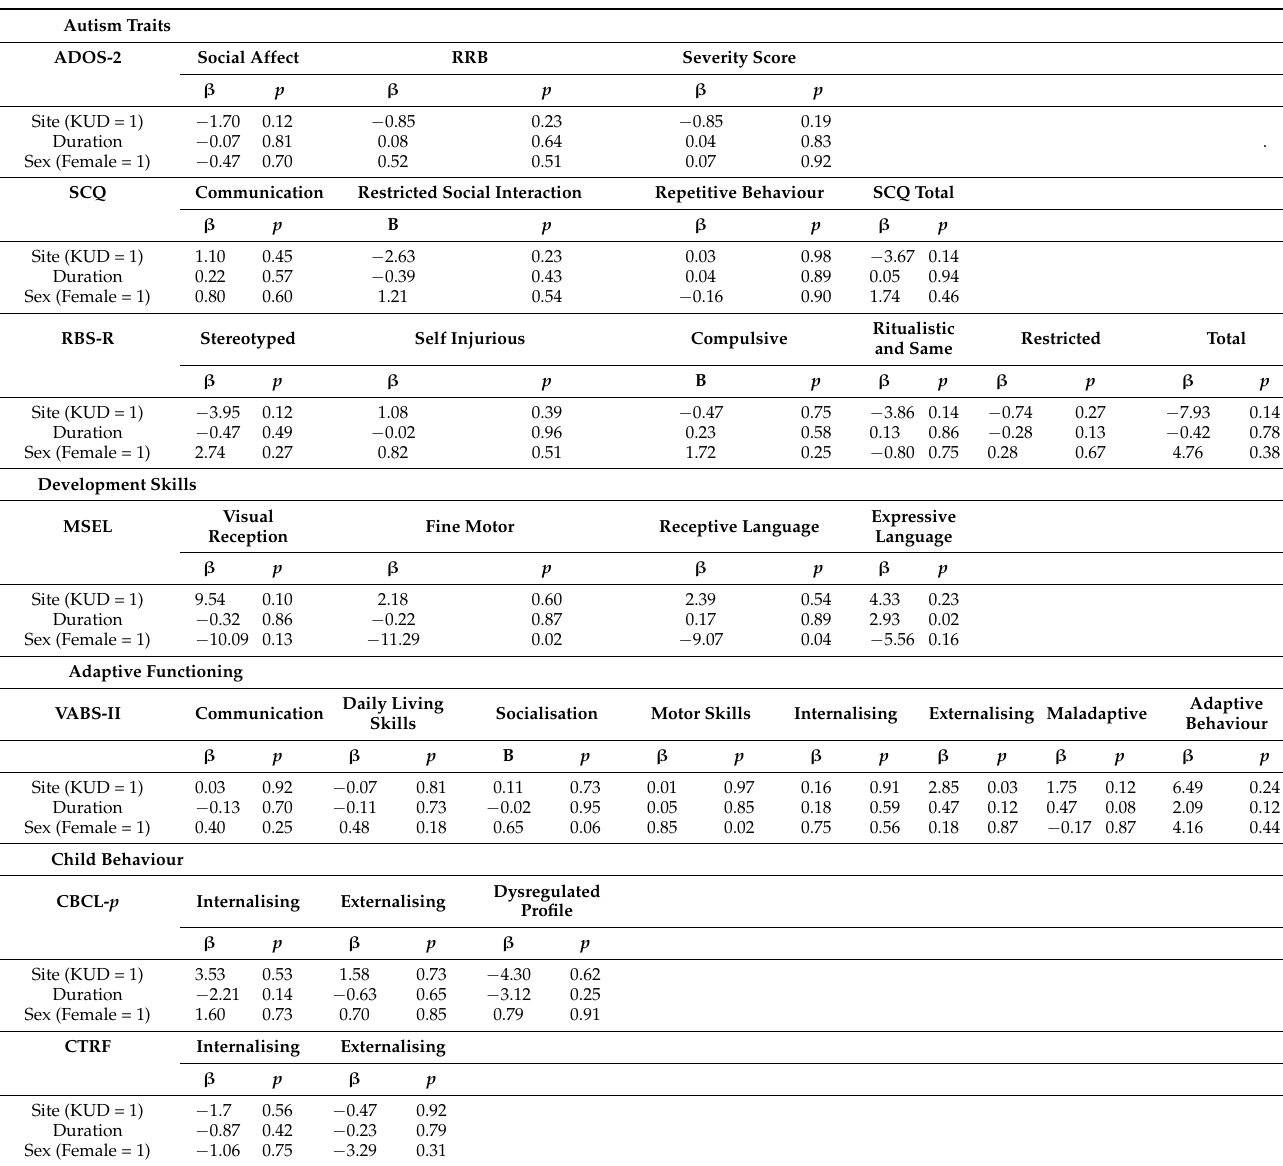
(Table 4), sex was significantly associated with receptive language (MSEL) and motor skills (VABS-II: fine and gross motor skills); male participants made greater improvements in receptive language than female participants ( β = − 9.07, p = 0.04) and also in fine motor skill development ( β = − 11.29, p = 0.02), both as measured by the MSEL. In contrast, females showed marginally greater improvements in motor skills (fine and gross motor) as measured by the VABS-II ( β = 0.85, p = 0.02). Duration was also seen to contribute to response to intervention for expressive language, where a one=month increase in duration resulted in improved expressive language skills ( β = 2.93, p = 0.02). Again, results need to be interpreted with caution as the sample size is small and sample sizes at follow up are substantially lower than at baseline. Table 4. Predictors of change in the severity of autism symptoms, child development skills, adaptive functioning and child